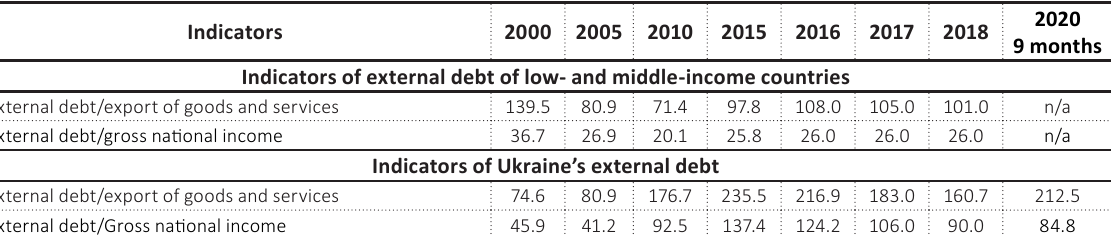
Table 1. Comparison of external debt indicators of low- and middle-income countries and Ukraine as a % Source: Compiled by the authors based on World Bank (2021), authors’